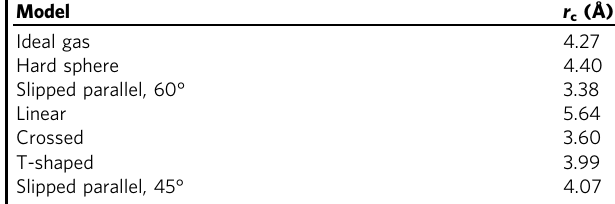
Table 2 Predicted critical radii r c associated with a density of 0.224 g cm − 3 , where 1/ e of the vibrational structure inherent to the CO 2 monomer spectrum remains, for various models